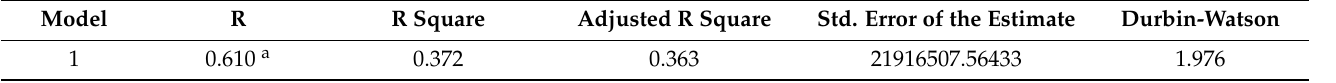
Table 1. Multivariate regression of market values of football players. Model summary b .